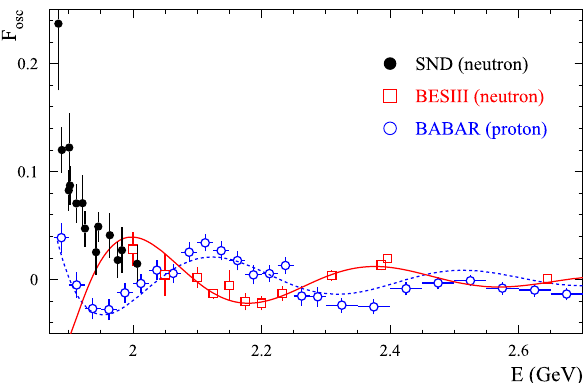
Fig. 16 The deviation of the proton and neutron effective form factor data from the dipole formula [see Eq. (13)]. The curves are the result of the simultaneous fit to the BABAR proton and BESIII neutron data described in the text Fig. 16, where the difference between the BABAR form fac- tor data and a function smooth on the GeV/ c scale are